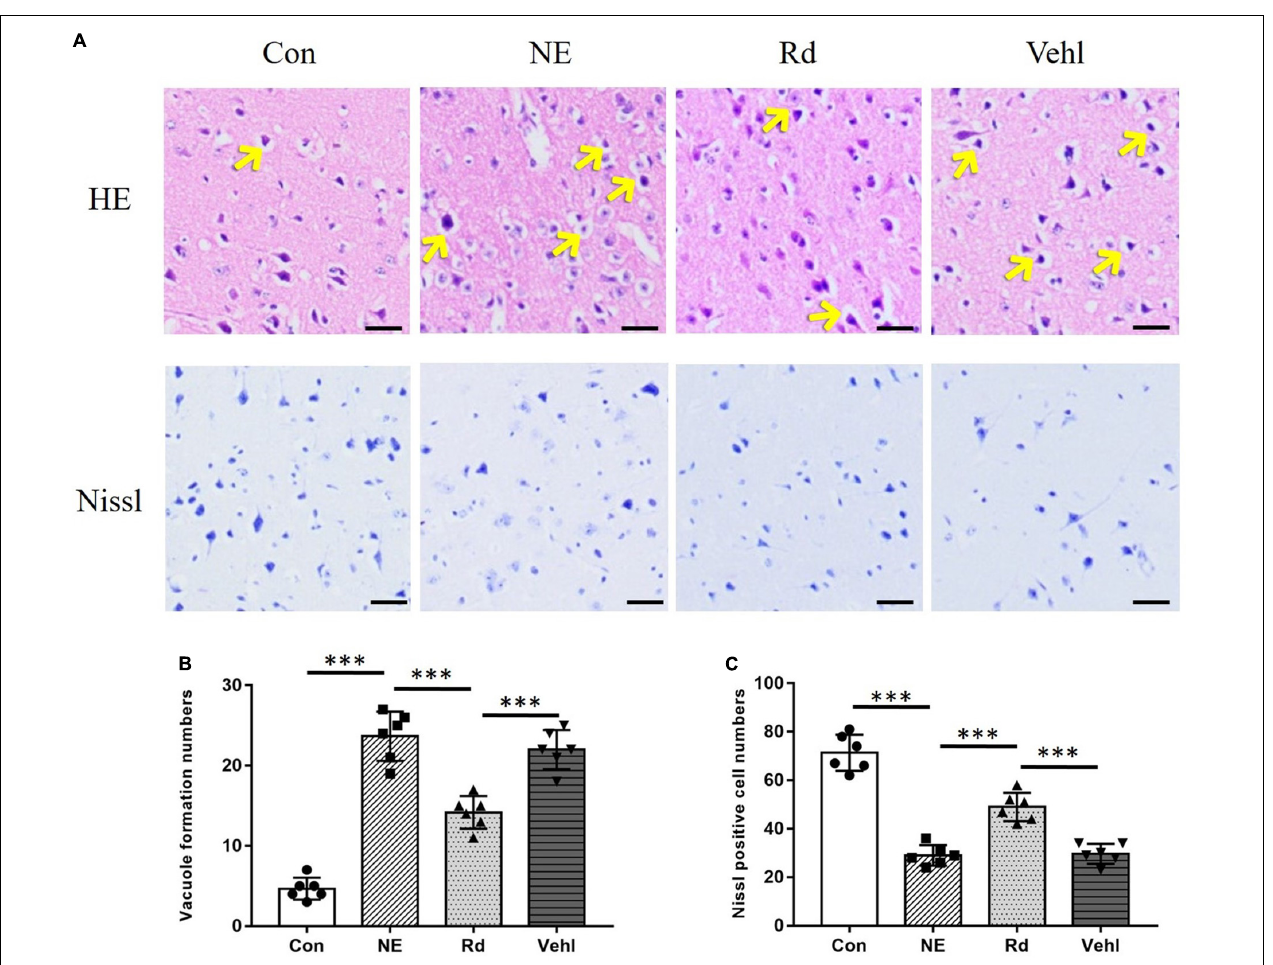
FIGURE 2 | Original images (A) and summarized data (B,C) of HE or Nissl staining in the auditory cortex of all groups after exposure to 115 dB (A) noise. The arrows indicate the vacuole formation in the neuron cells; magnification × 400, scale bar = 50 µ m. N = 6 in HE or Nissl staining. The values are presented as the means ± SE. *** p <